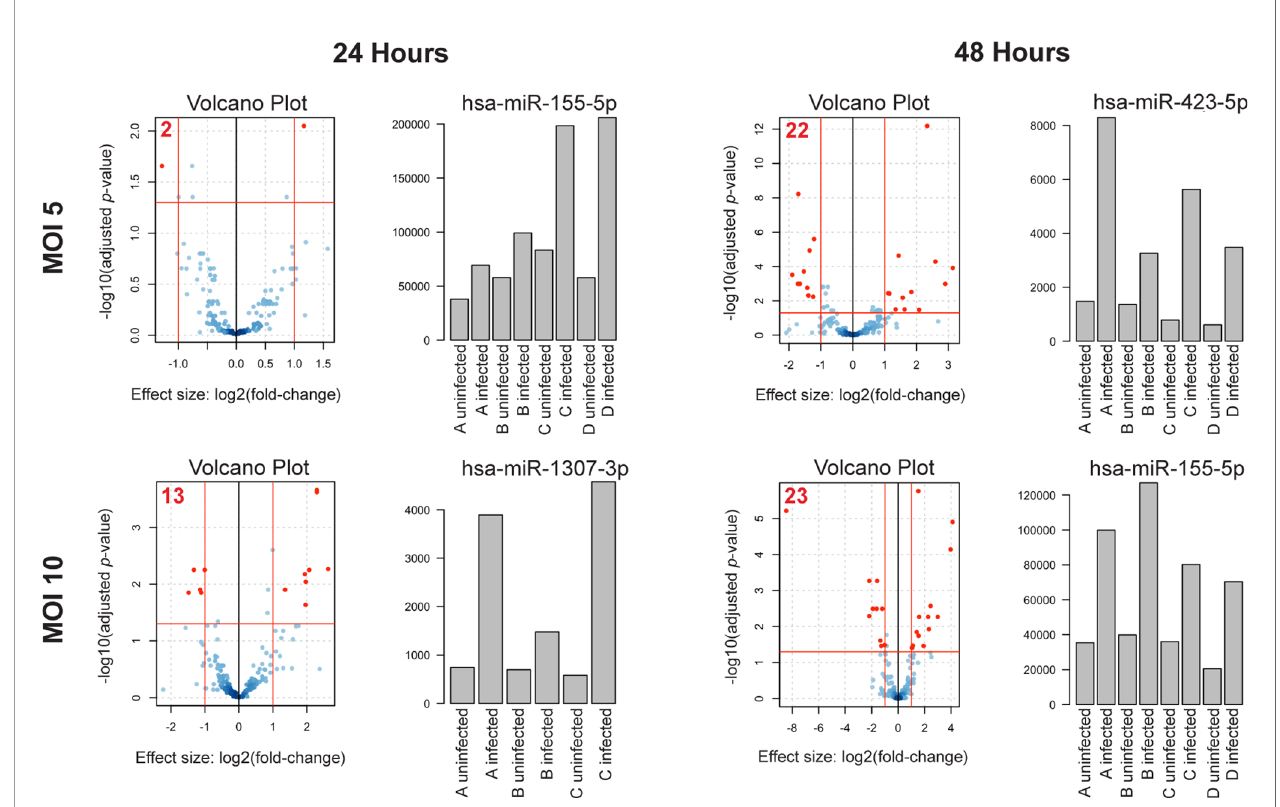
FIGURE 1 | miRNA dysregulation increases with time post-infection and MOI. Volcano plots of differentially expressed miRNAs in each condition. n = 4 independent human donors. Red lines represent signi fi cance thresholds, red numbers represent total number of signi fi cantly DE miRNAs. Bar plots to the right of each volcano plot show the most signi fi cantly dysregulated miRNA for that condition. Bar plot y-axis shows normalized read